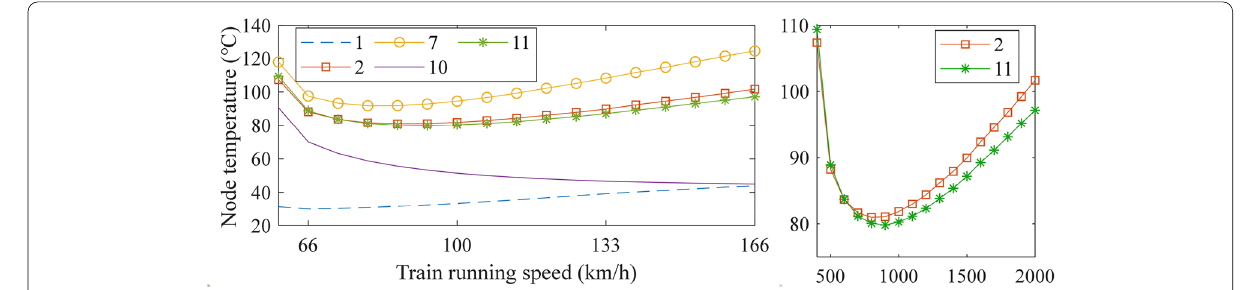
Figure 8 Node temperature change with the train running